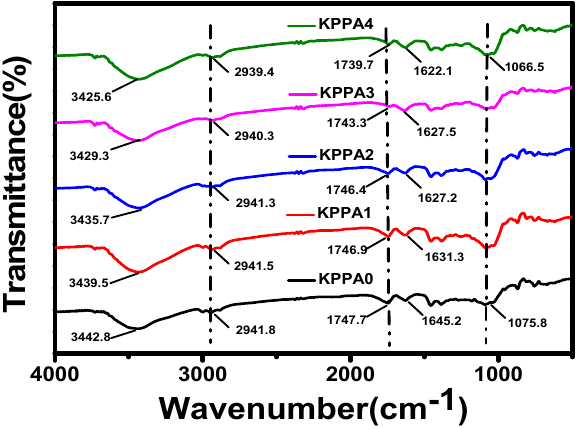
Figure 4. FTIR spectra of the KPPA0, KPPA1, KPPA2, KPPA3 and KPPA4 cryogels.